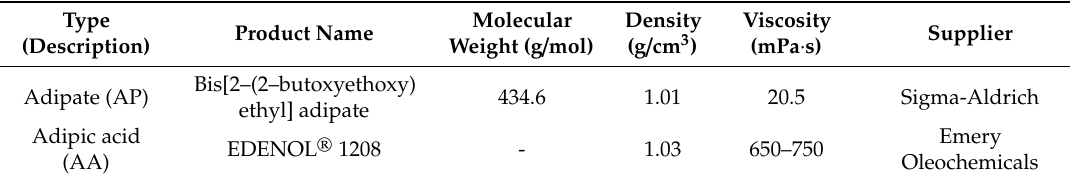
Table 1. Basic properties of the plasticizers used in this